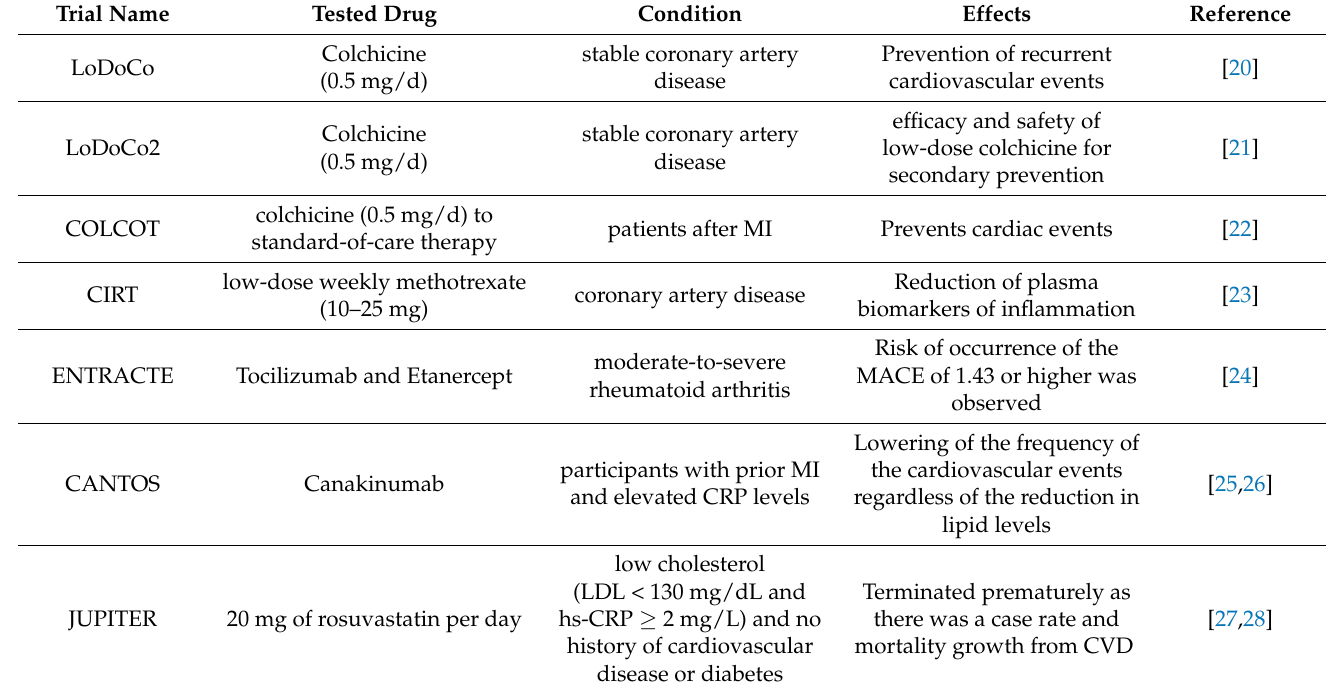
Table 1. Summary of clinical trials data, which examined the effects of anti-inflammatory drugs on various cardiovascular conditions. The table contains the name of the trial, the name of the tested drug, the condition in which it was examined, the effects that were observed, and the study